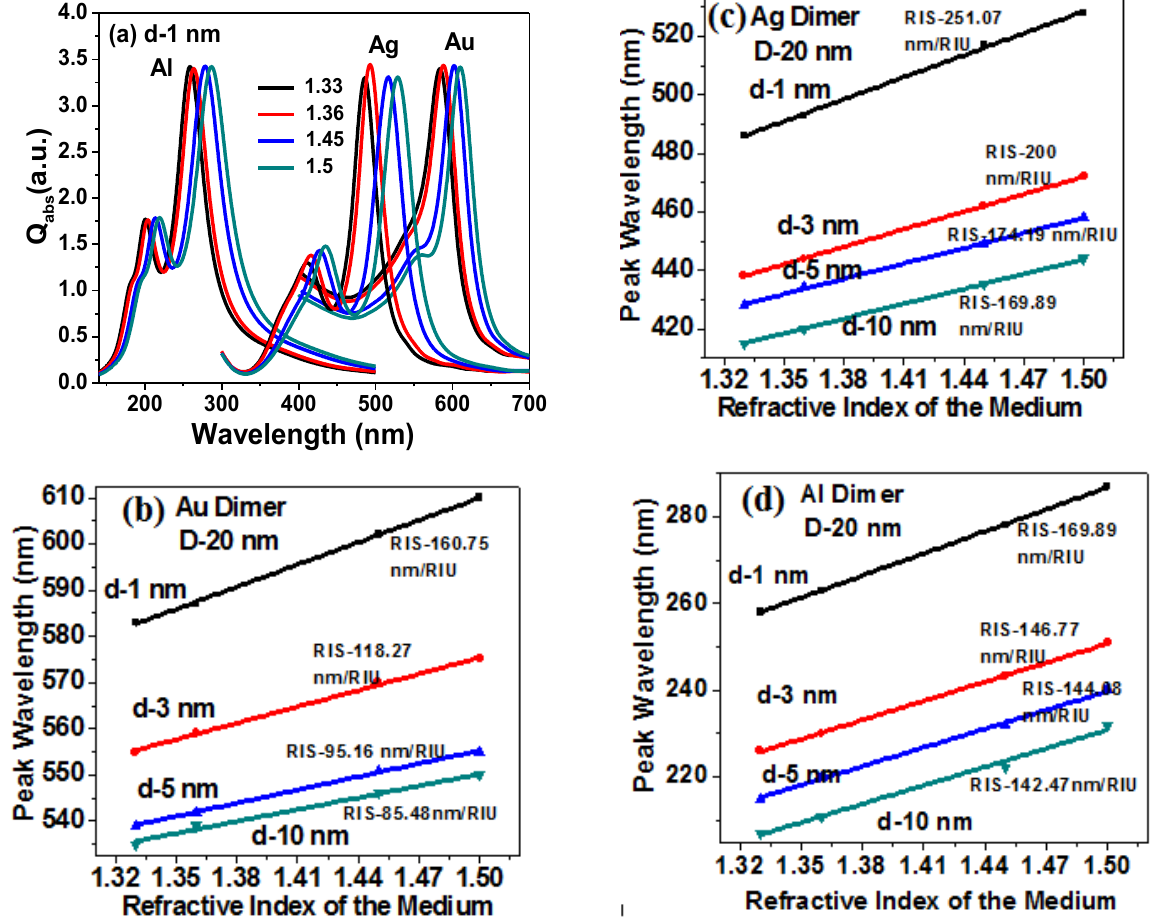
Figure 7: (a) Calculated absorption spectra of Au, Ag and Al homo-dimer. The refractive index of the medium is 1.33, 1.36, 1.45 and 1.5. The particle size is 20 nm and the interparticle spacing is 1 nm .Interparticle spacing dependent shift in peak wavelength with refractive index of the medium for (b) Au, (c) Ag and (d) Al homo-dimer